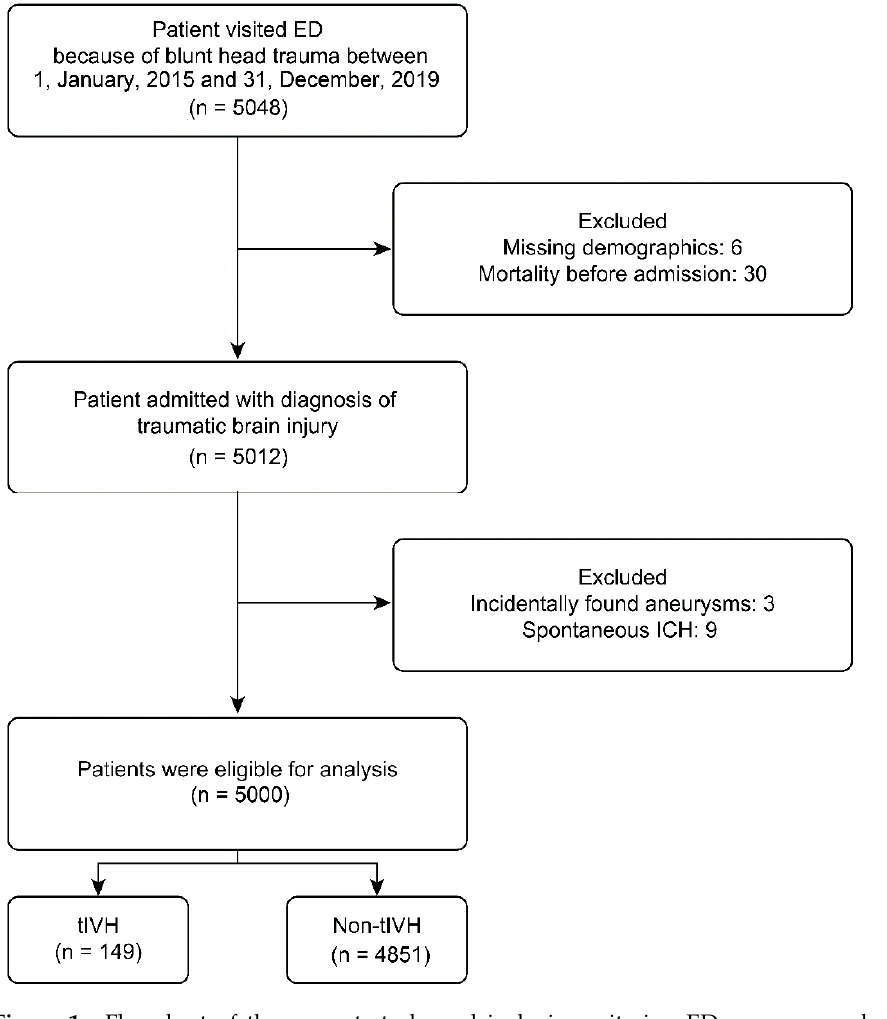
Figure 1. Flowchart of the current study and inclusion criteria. ED: emergency department; ICH: intracerebral hemorrhage; tIVH: traumatic intraventricular